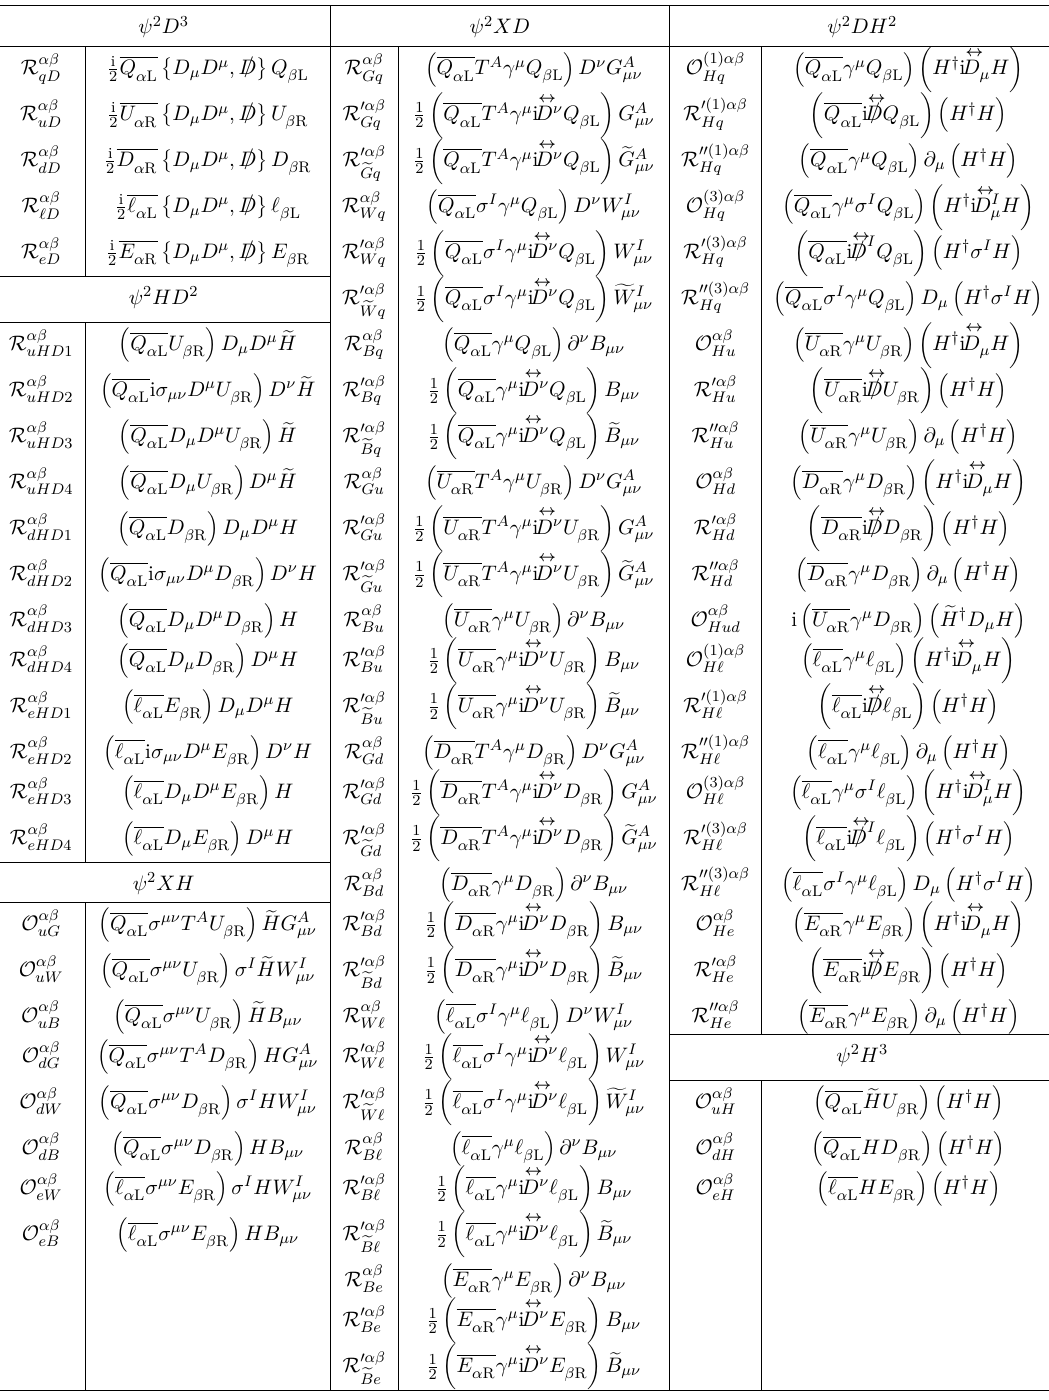
Table 2 . Two-fermion operators in the Green’s basis in the